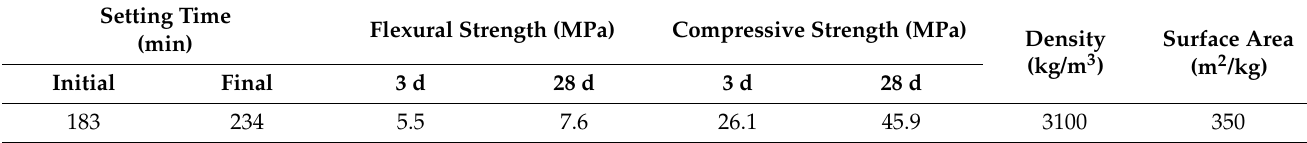
Table 1. Properties of Portland Cement.